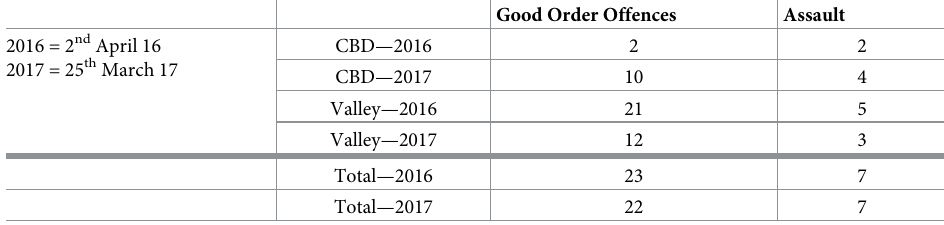
Table 3. Big night out crimes against the person and good order offences.